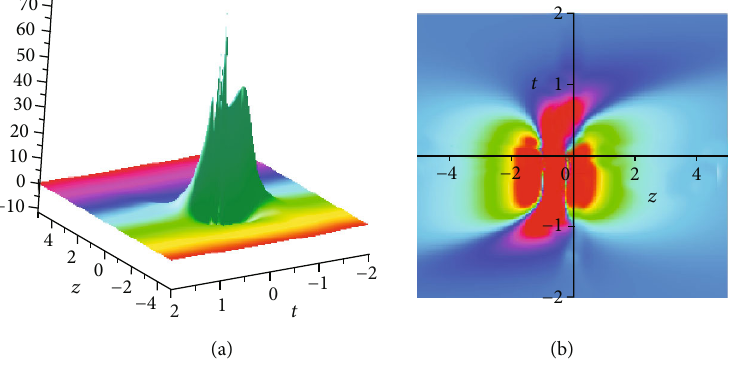
Figure 18: Plots of lump-periodic (77).